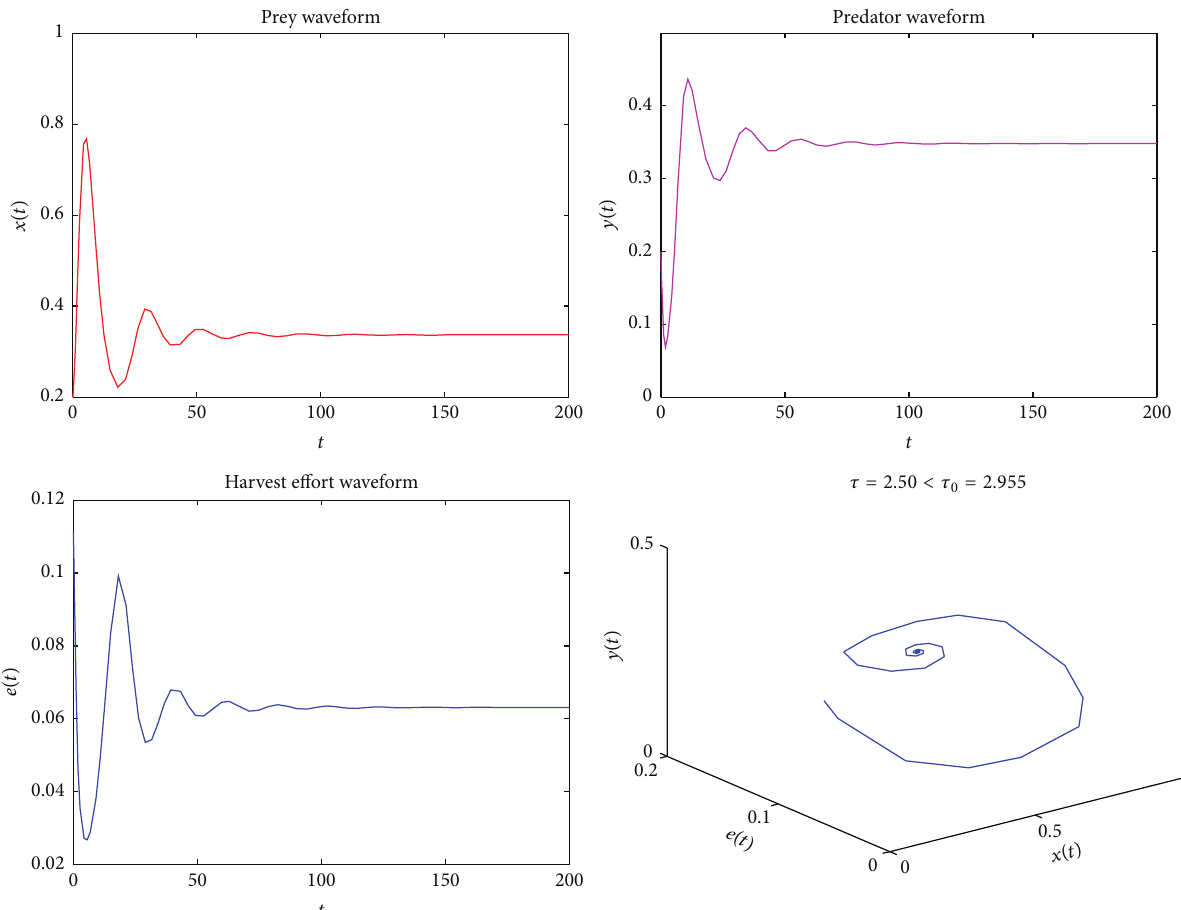
Figure 4: The positive equilibrium 𝑃 ∗ of system (6) with 𝜏 = 2.950 < 𝜏 0 = 2.955 is locally asymptotically